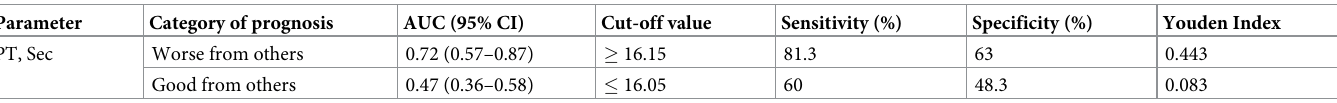
Table 6. Prognostic values of baseline basic coagulation tests among COVID-19 patients attending at the Tibebe Ghion Specialized Hospital, COVID-19 treatment center 2021 (n = 110). Parameter